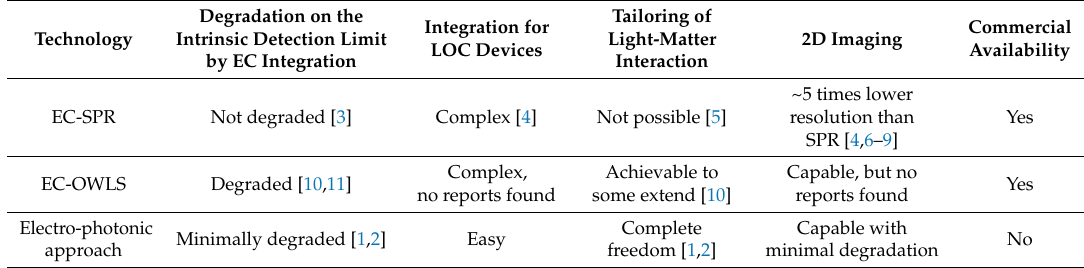
Table 1. Comparison between EC-SPR, EC-OWLS and electro-photonic sensing. Lab-on-chip (LOC).